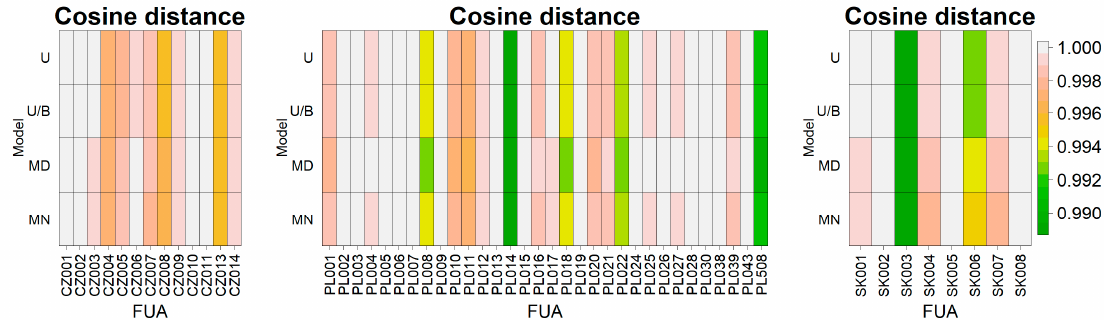
Figure 5. The cosine distance between the LUC models and actual LUC in individual FUAs in Czechia, Poland, and Slo- vakia.